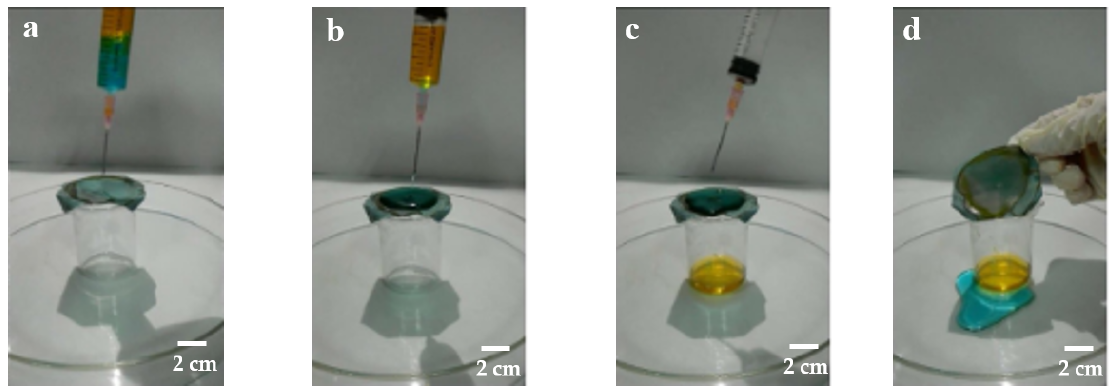
Figure 3. Separation e ff ect diagram of oil–water mixture using modified copper meshes: ( a ) separation of preparation; ( b ) separation begins; ( c ) in separation; ( d ) end of separation.